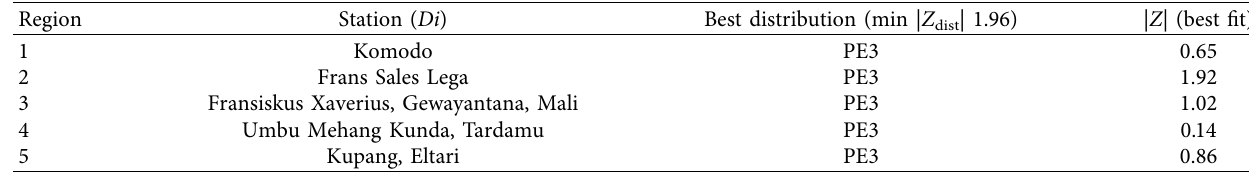
Table 4: Goodness-of-fit test for rainfall data in the five homogeneous regions.